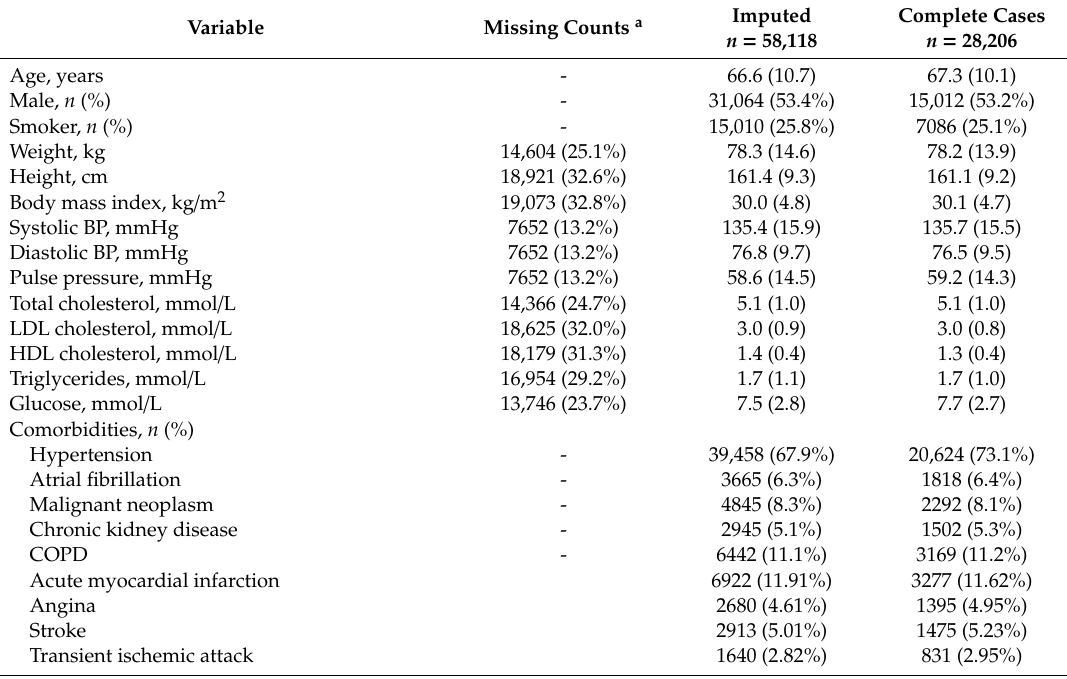
Table A1. Missing counts and comparison of baseline characteristics of the whole study population for the imputed and complete-cases